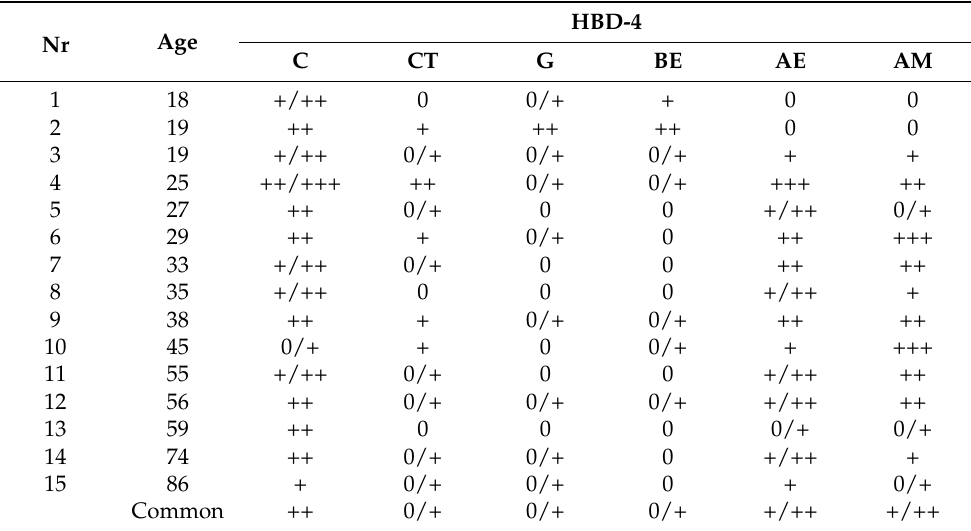
Table 2. Relative number of HBD-4-positive structures in the healthy lung structures: cartilage, connective tissue, glands, bronchial epithelium, alveolar macrophages and alveolar epithelium. Nr